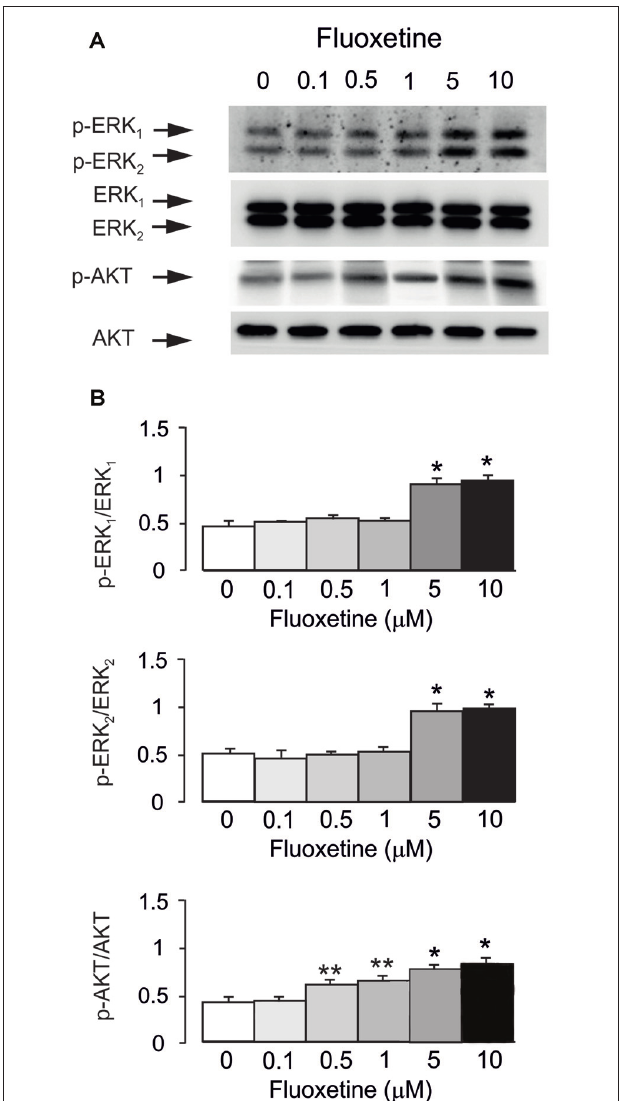
FIGURE 1 | Acute treatment with fluoxetine induced extracellular-regulated kinase (ERK) 1 / 2 and AKT phosphorylation in astrocytes. Cells were incubated for 20 min in the absence of any drug (0 µ M fluoxetine, control) or in the presence of 0.1, 0.5, 1, 5, or 10 µ M fluoxetine. (A) Immunoblot from a representative experiment. Similar results were obtained from three independent experiments. Average ERK phosphorylation was quantitated as ratios between p-ERK 1 and ERK 1 and between p-ERK 2 and ERK 2 , or average AKT phosphorylation was quantitated as ratio between p-AKT and AKT (B) . SEM values are indicated by vertical bars. ∗ Indicates statistically significant ( P < 0.05) difference from 0, 0.1, 0.5 and 1 µ M fluoxetine; ∗∗ indicates statistically significant ( P < 0.05) difference from all other groups but not from each